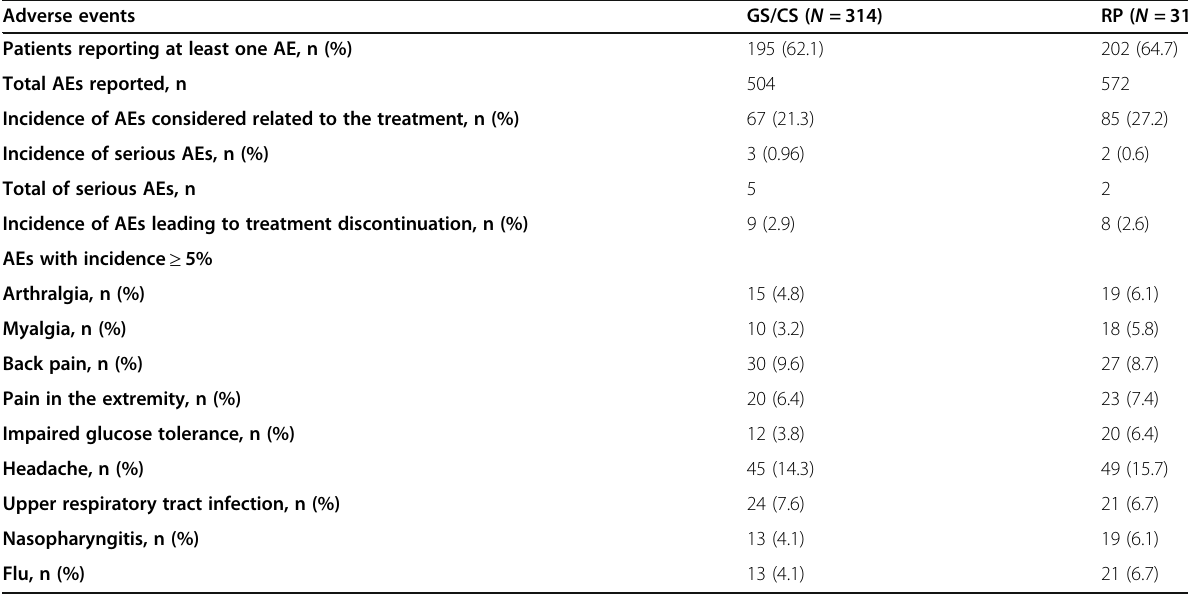
Table 4 Adverse events observed in the safety population Adverse events GS/CS ( N = 314) Patients reporting at least one AE, n (%) Total AEs reported, n Incidence of AEs considered related to the treatment, n